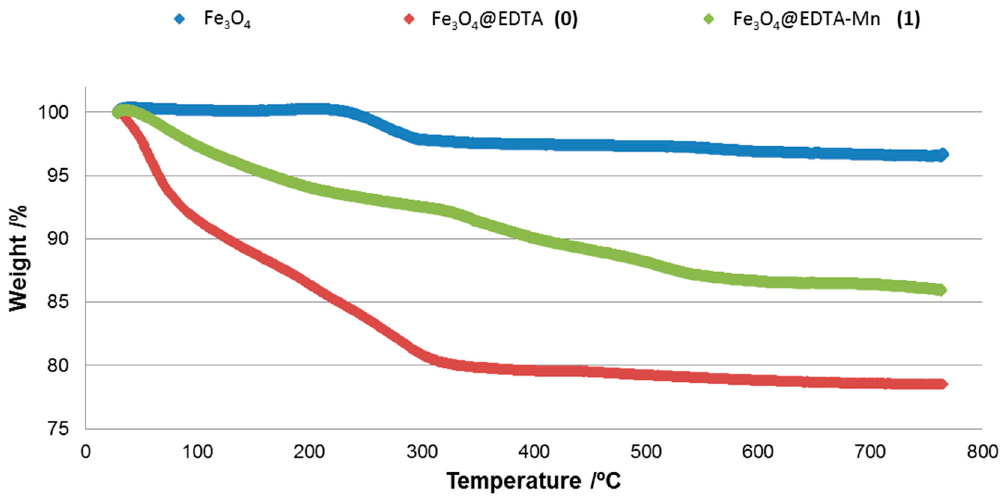
Figure 5. Thermogravimetric curves of Fe 3 O 4 (magnetite), Fe 3 O 4 @EDTA ( 0 ) and Fe 3 O 4 @EDTA ‐ Mn 2+ ( 1 )